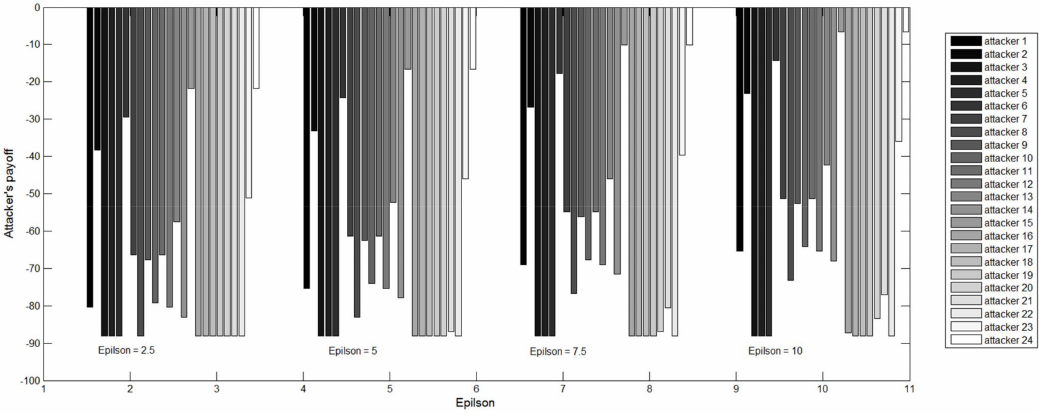
Figure 5. Attacker’s payoff under different rationality levels of